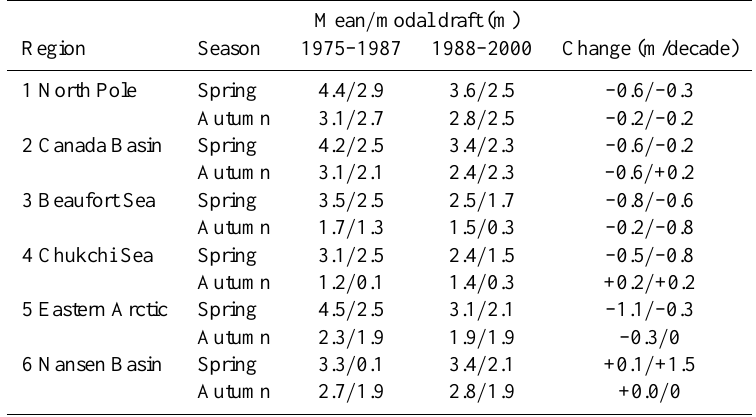
Table 2. Regional Spring and Autumn mean and modal draft in 1975–1987 and 1988–2000. The difference between regional mean drafts of these two periods is normalized over a